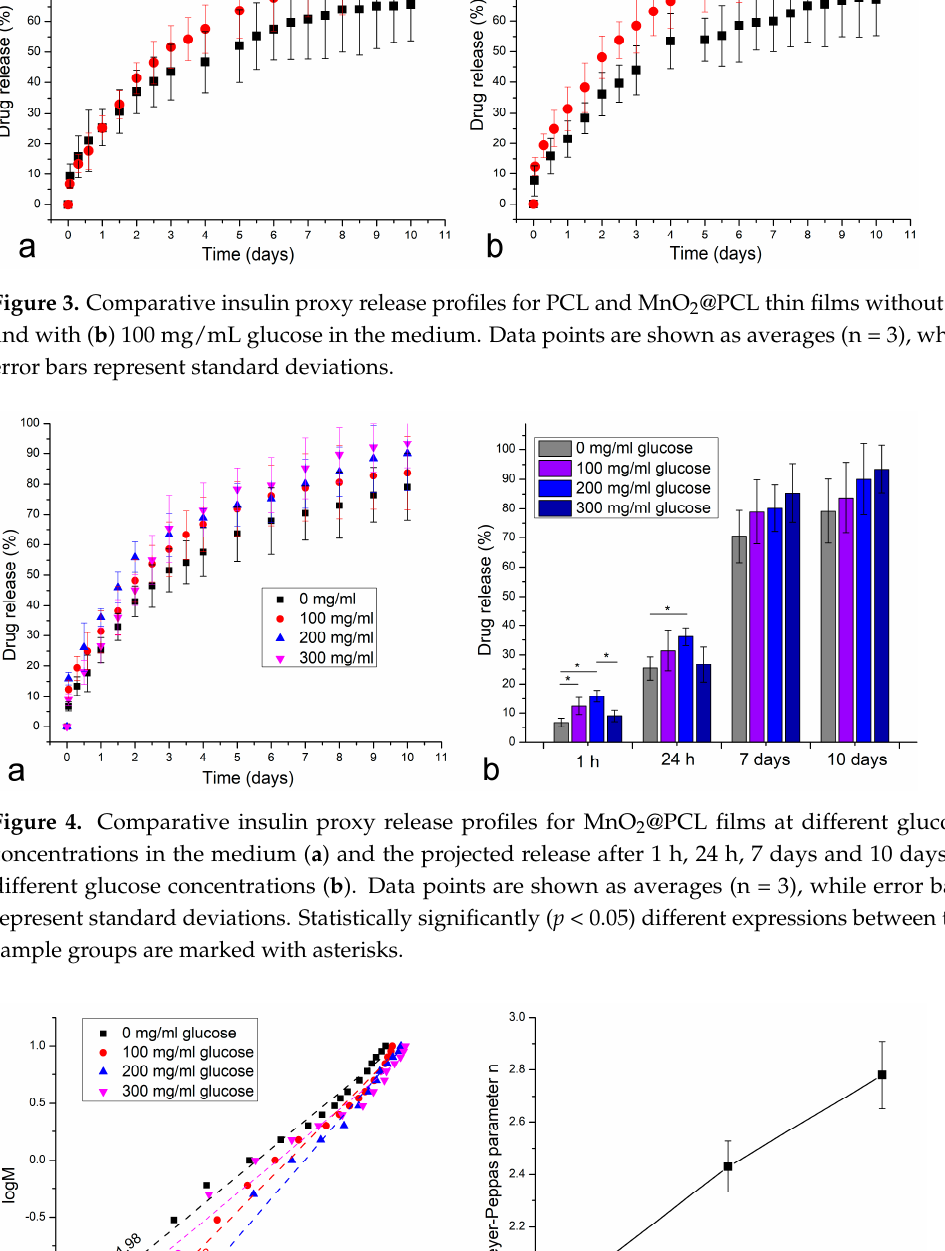
Figure 5 Figure 5. Korsmeyer–Peppas fits to the logarithmic functions of the degree of reaction completion, M, versus time for the release of the insulin proxy from MnO 2 @PCL films at different concentrations of glucose in the medium ( a ). Linear dependence of the release mechanism-indicative Korsmeyer– Peppas parameter n versus the concentration of glucose in the medium ( b